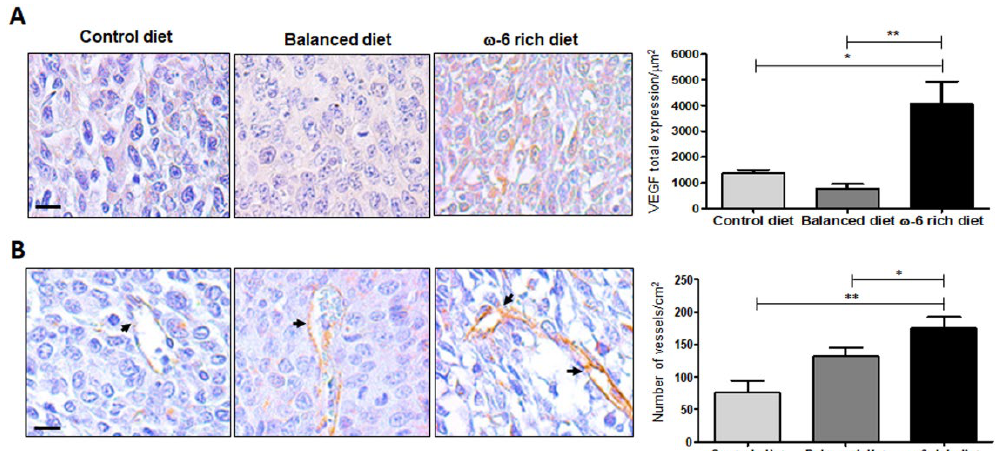
Figure 4. ω -6 PUFAs induce increased vascularization in tumors. ( A ) Representative example of tumor sections and analysis of VEGF-A expression, evaluated by immunohistochemistry, statistical differences are shown (* p < 0.05 and ** p < 0.01). ( B ) Quantification of blood vessels immunostained with CD31, in the different groups of mice fed with control diet, balanced diet and diet rich in ω -6, on the left side are representative micrographs of the blood vessels denoted by black arrows, right side, the analysis of blood vessels per cm 2 is shown, (* p < 0.05 and ** p < 0.01). Scale bar: 10 μm. Values represent mean + SEM, n = 5.